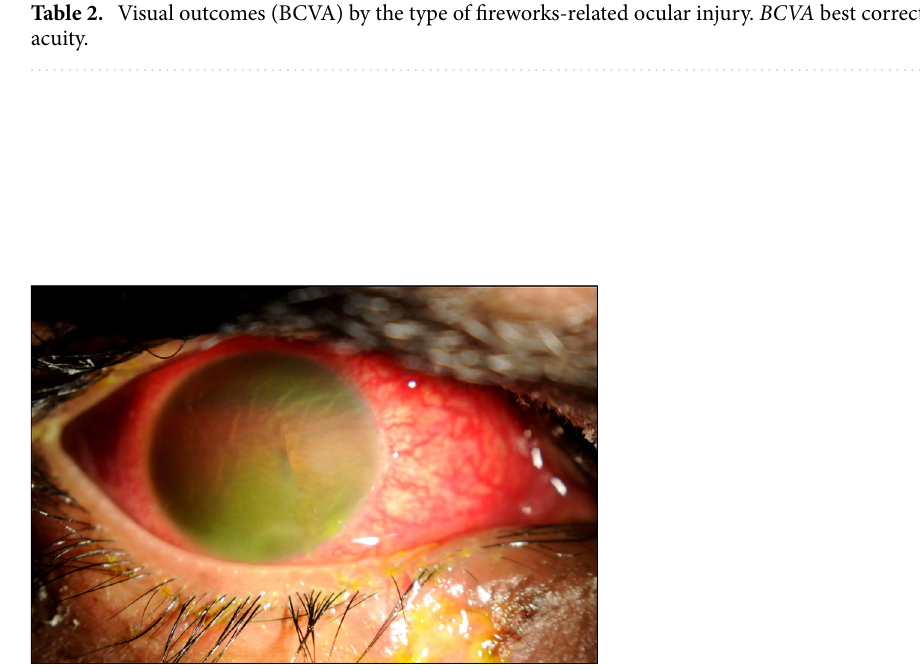
Figure 1. Slit-lamp photo showing hyphema caused by fireworks